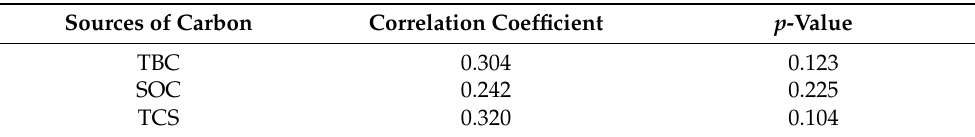
Table 4. Correlation of Ds with total biomass carbon (TBC), soil organic carbon (SOC) and total carbon stocks (TCS); all in Mg ha − 1